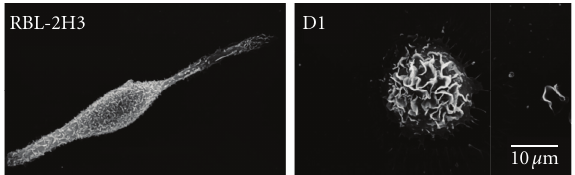
Figure 3: Ganglioside-deficient D1 cells have an altered morphol- ogy. By scanning electron microscopy, RBL-2H3 cells are spindle shaped and their surface is covered with short microvilli. In contrast, D1 cells are rounded and their surface is covered with large membrane ru ffl es.